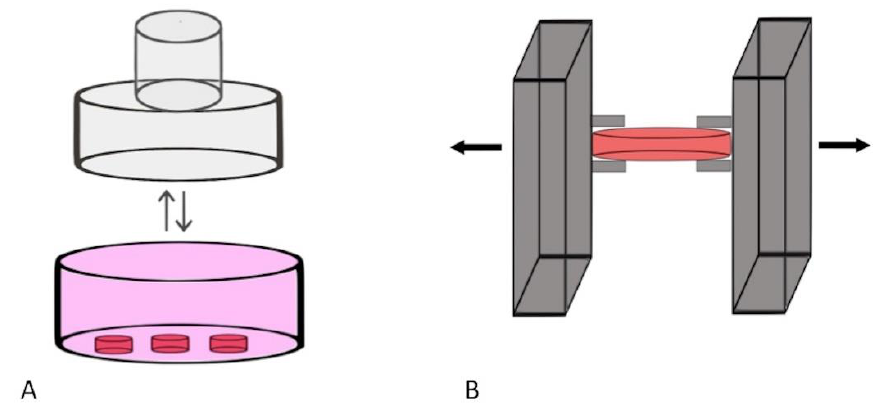
Figure 2. Dynamic physiological culture techniques that replicate dynamic mechano-transduction physiology. ( A ) an illustrative example of the dynamic cyclic compression technique. A vertical pressure load is applied to the cultured tissue. The loading weight applied can be altered in addition to whether the pressure load remains constant over a sustained period of time or is intermittent in nature. The pink component of the image is representative of the media within the culture plate, whereas the small red cylinders portray the cultured tissue; ( B ) an illustrative example of the mechanical expansion and stretching technique. The tissue is initially secured and subsequently a uniaxial stretch load is directly applied to the tissue. Applied tension can either be sustained and progressive or episodic. The red cylinder represents the cultured tissue. Table 1. Characteristics of studies utilising dynamic physiological culture to replicate dynamic mechano-transduction physiology.